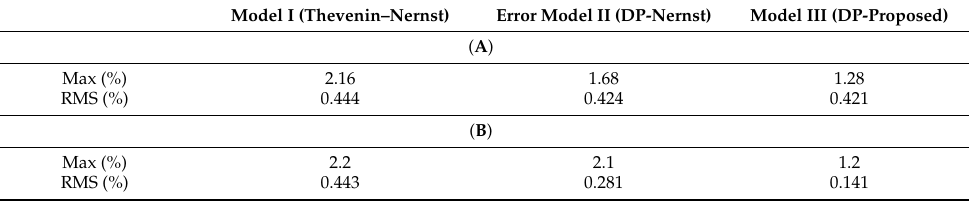
Table 5. ( A ) Error comparison—NEDC driving cycle. ( B ) Error comparison—WLTC driving